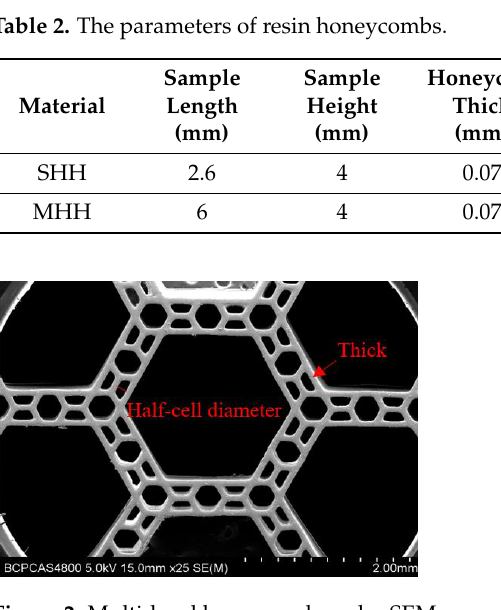
Figure 2. Multi-level honeycomb under SEM.